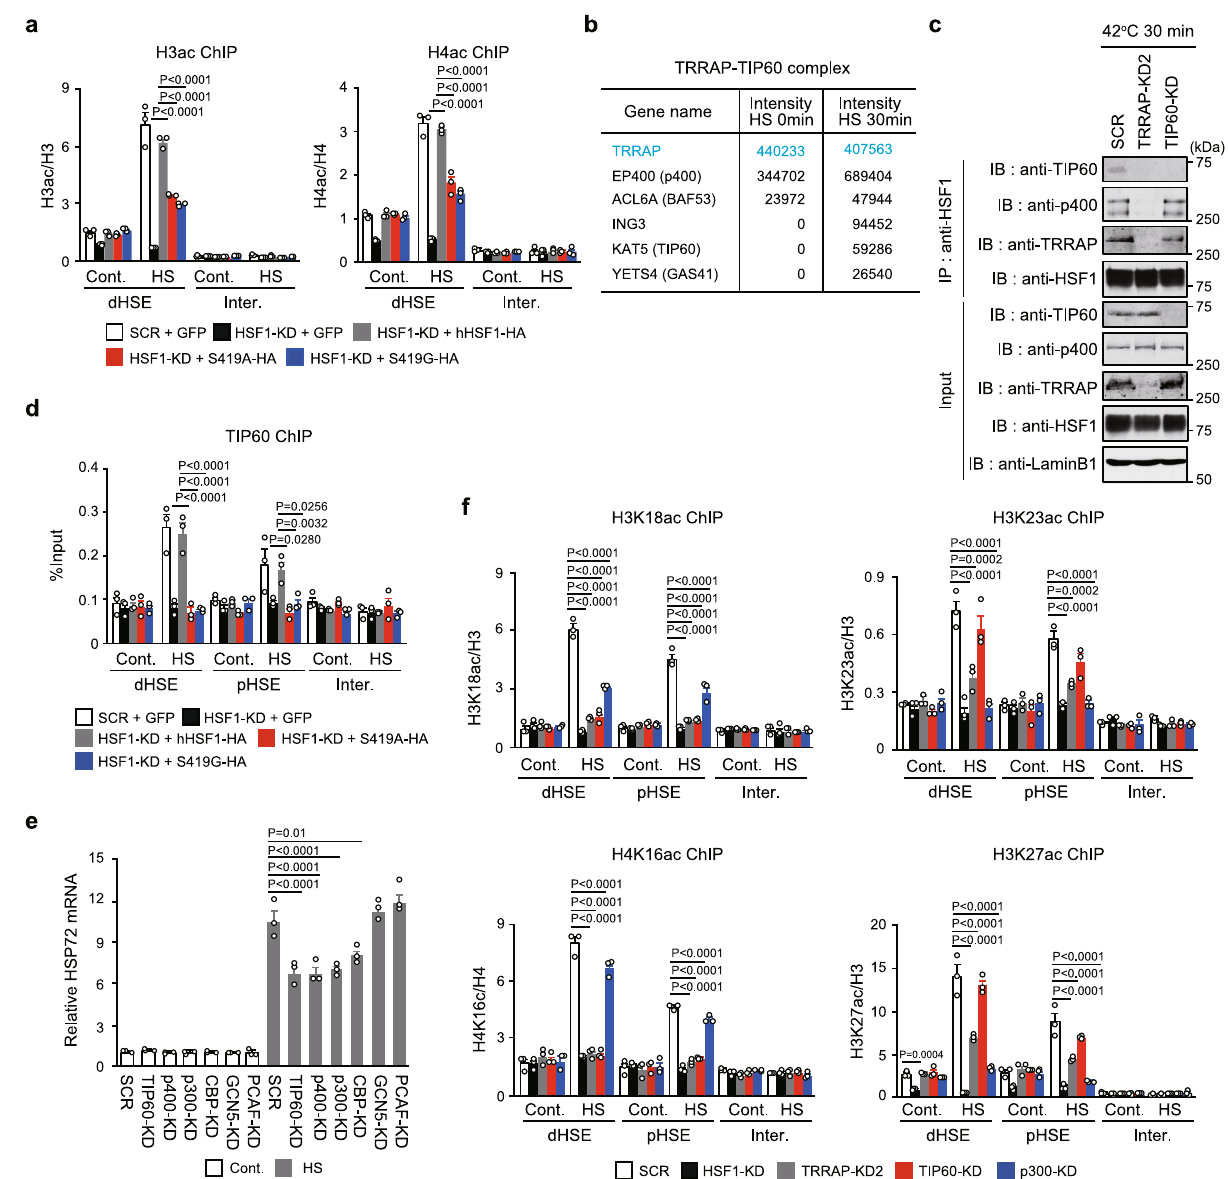
Fig. 3 | TRRAP-TIP60 complex isresponsiblefor histone acetylation at speci fi c residues.a Occupancy of pan-acetylated histone H3 and H4 in HSP72 promoter. ChIP assay was performed using HeLa cells treated as described in Fig.